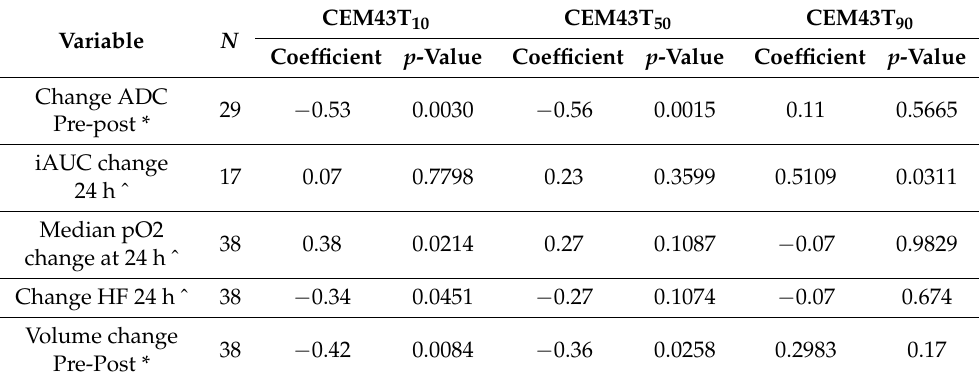
Table 2. CEM43Tx vs. change in volume, ADC, pO2, HF, iAUC: Thermal Dose Fractionation Trial. Variable N